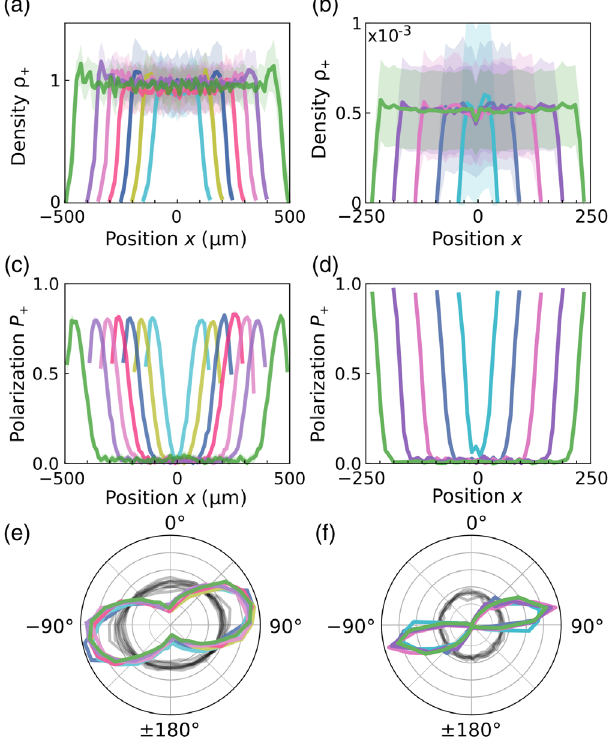
FIG. 3. (a),(b) Density of þ 1 = 2 defects in (a) monolayers of HT1080 cells in stripes normalized by the density at the center of the stripe and (b) simulated chiral active nematics ( α ¼ − 10 , τ ¼ − 2 . 5 ). For HT1080 monolayers, defect density is normalized to 1 in the bulk. (c),(d) Polar order parameter of þ 1 = 2 defects in (c) monolayers of HT1080 cells and (d) simulated chiral active nematics, showing orientational ordering of defects close to the boundary. (e),(f) Polar histogram of defect orientation close to the boundaries for (e) monolayers of HT1080 cells and (f) simulated chiral active nematics. The defects are on average aligned perpendicular to the boundary with a chiral tilt. In the bulk there is no net alignment (gray). Color code indicates the width of the stripe as in Fig. 1. Simulation units and parameter values are given in the Appendix.